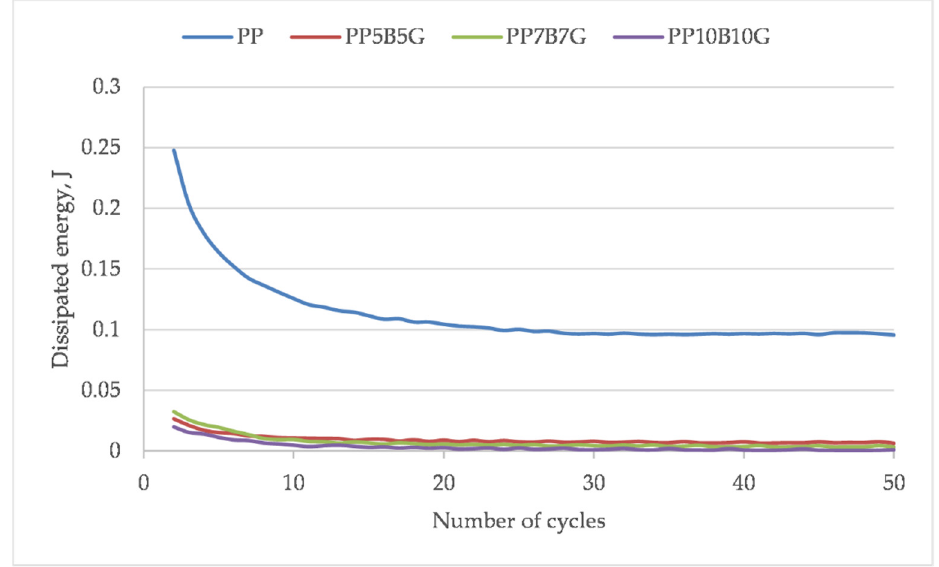
Figure 10. Dissipation energy of successive hysteresis loops of sample load and unload.